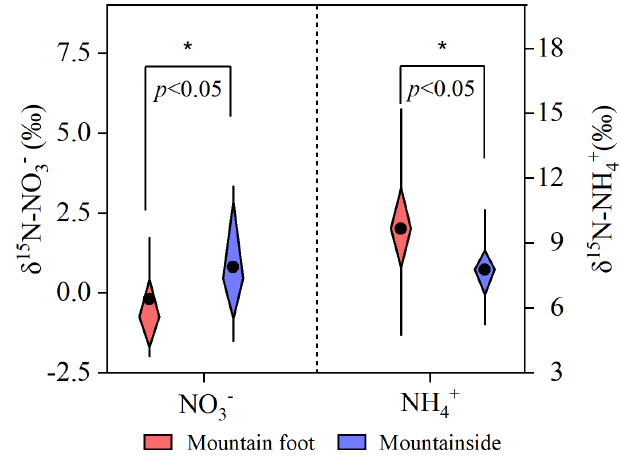
Figure 10. Nitrate and ammonium δ 15 N values at the two sampling sites in the